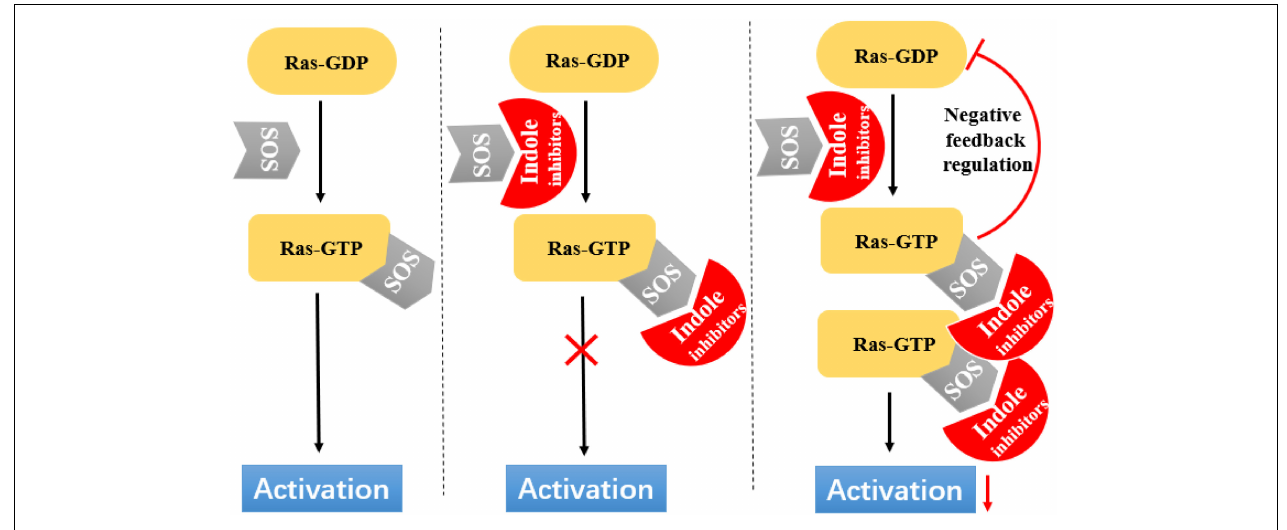
FIGURE 6 | Indole derivatives interfere with Ras activation by inhibiting SOS-mediated nucleotide exchange